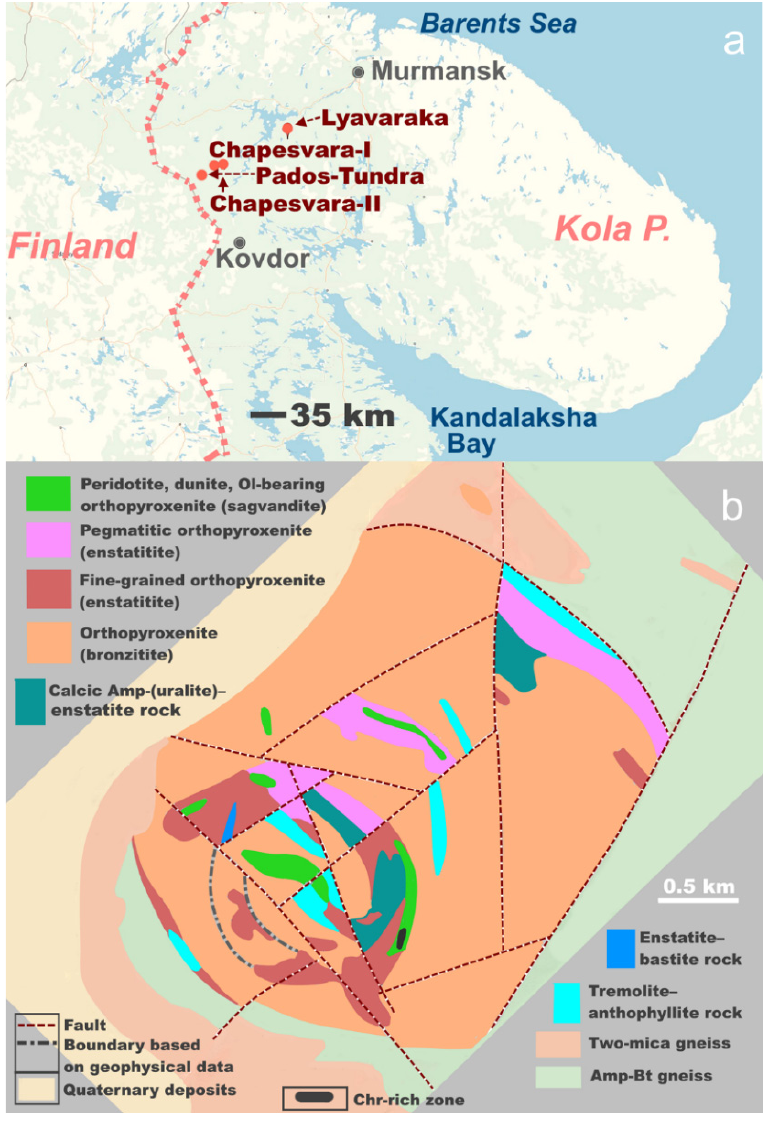
Figure 1. ( a ) shows the location of the Lyavaraka complex (68°25 ′ N, 31°32 ′ E) relative to the Pados-Tundra layered intrusion and Chapesvara (I and II) zoned sills, in the Kola Peninsula of northwestern Russia. ( b ) is a simplified geological map of the Lyavaraka complex, after [20]. All symbols used in Figure 1 and in the text conform to [22].